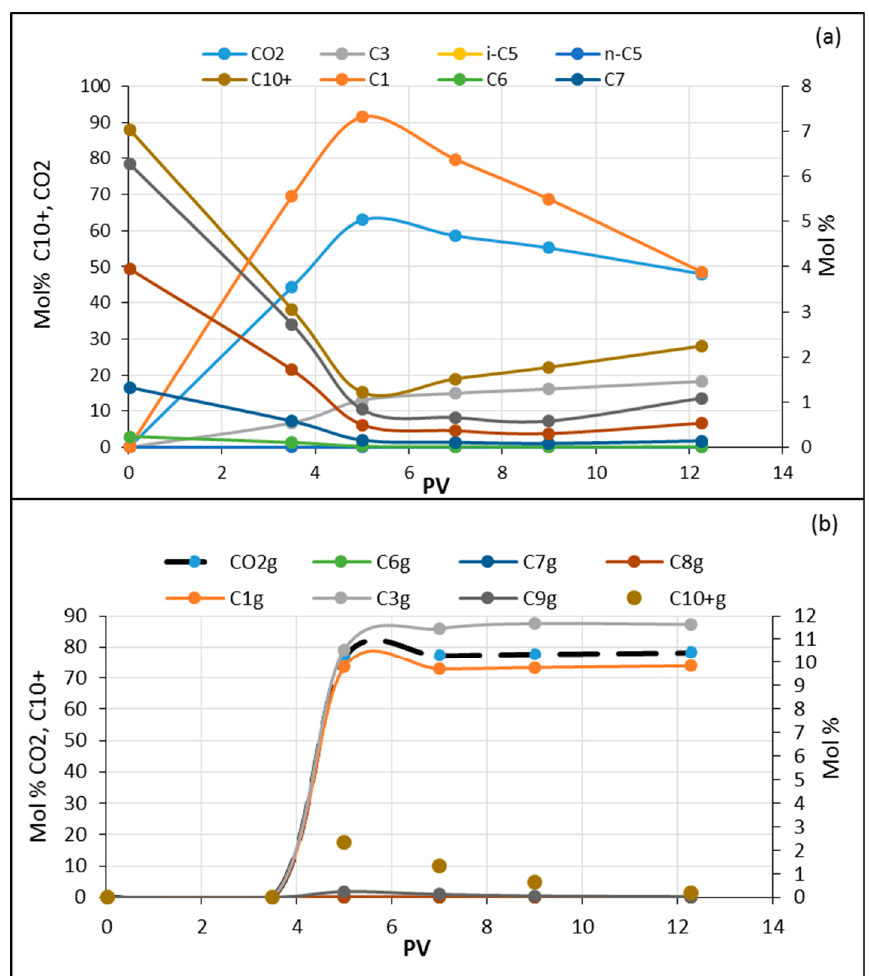
Figure 8. Dynamic composition as a function of injected pore volume of CO 2 /C1/C3 into crude oil ( a ) in liquid phase and ( b ) in vapor phase.